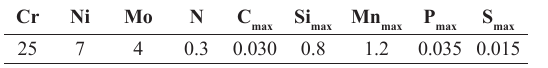
Table 1. SAF 2507 tube chemical